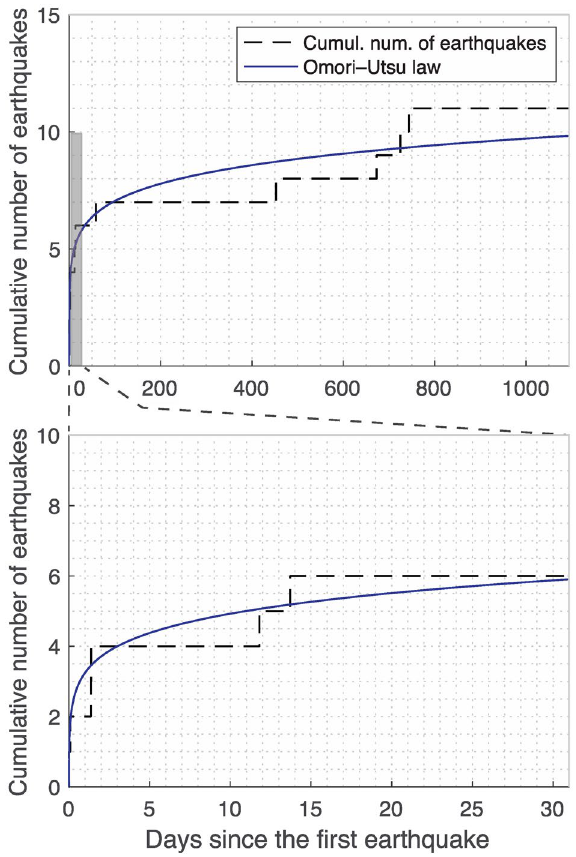
Figure 2. Cumulative number of earthquakes with respect to time. The data set of the Seismological Centre- Global Earthquake ver 6.0 Global Instrumental Earthquake Catalogue was used without regional restrictions. The cumulative number of earthquakes is demonstrated by the stair plot. The best-fit curve of the Omori–Utsu law is shown in